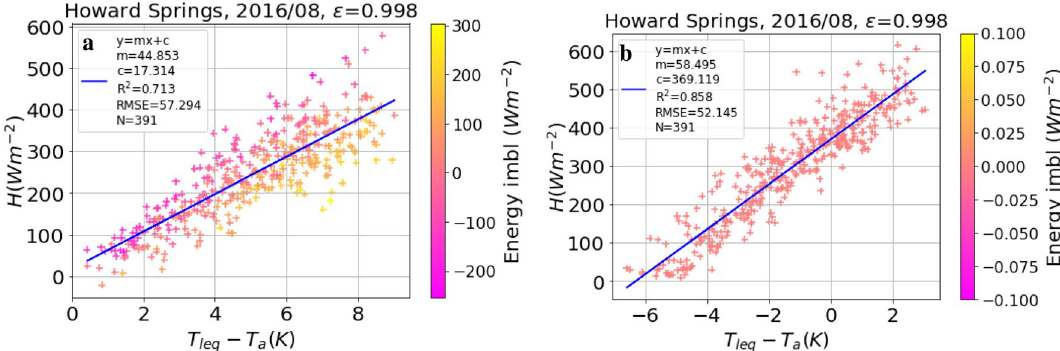
Figure 5. Sensible heat flux as a function of surface-to-air temperature difference based on Eq. (8) ( H = m ( T s − T a ) + c ). Same analysis and legends as in Fig. 4c), but ( a ) after adding 40 Wm − R lup , and ( b ) after closing the energy imbalance using a Bowen ratio closure scheme.